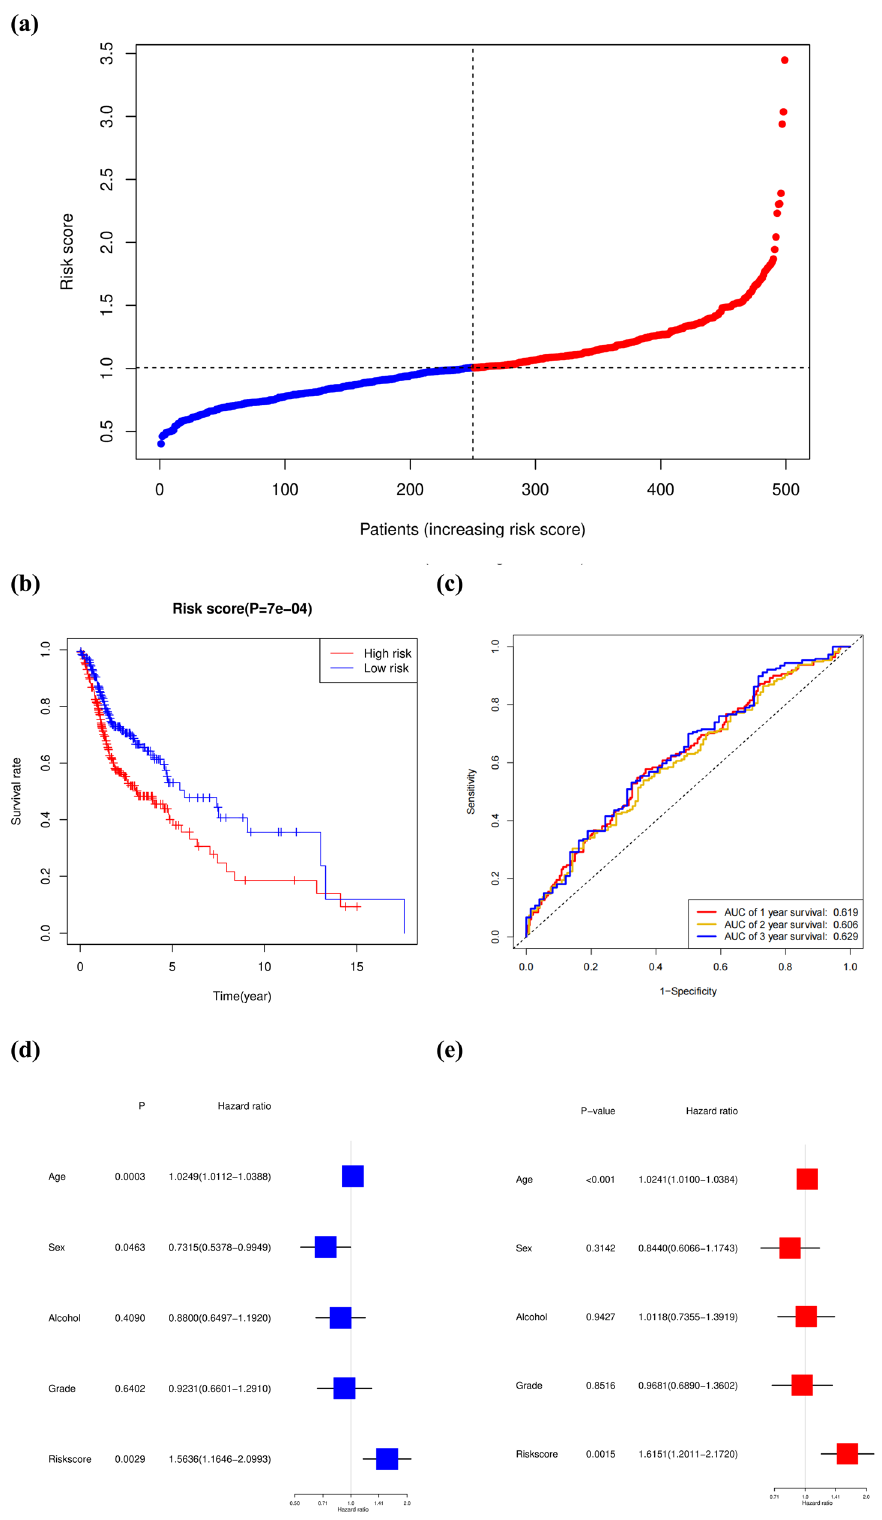
Figure 8: Establishment and validation of a prognostic model based on the key genes. ( a ) Distribution of patients based on the risk score. ( b ) Kaplan – Meier curves for the survival rate of patients in the high - risk and low - risk groups based on TCGA database. ( c ) Time - dependent ROC curves for OS. ( d ) Univariate Cox regression analysis of OS for fi ve risk - related factors. ( e ) Multivariate Cox regression analysis of OS for fi ve risk - related